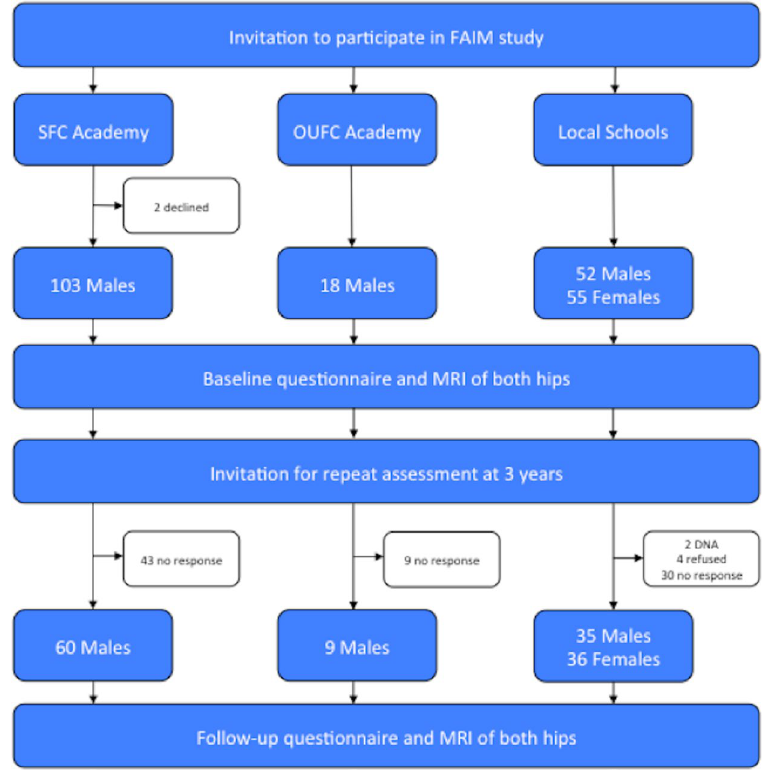
Figure 1. Recruitment flowchart for